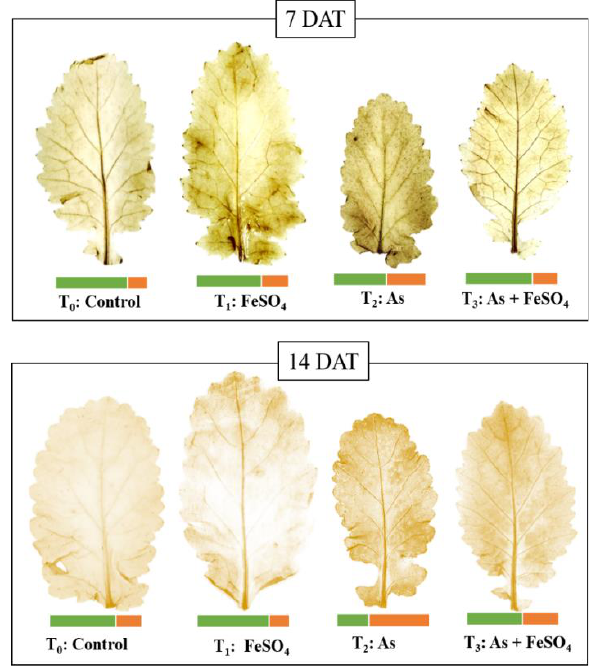
Figure 5. Detection of oxidative stress by hydrogen peroxide localization in the leaf of Brassica juncea during treatments of iron sulfate (T 1 : +FeSO 4 ), arsenic stress (T 2 : +As) and iron sulfate supplementation during As stress (T 3 : As+FeSO 4 ) studied 7 and 14 days after treatment (DAT). The heatmap shows a comparison of the normal scenario (green color) against H 2 O 2 levels (orange color) in the